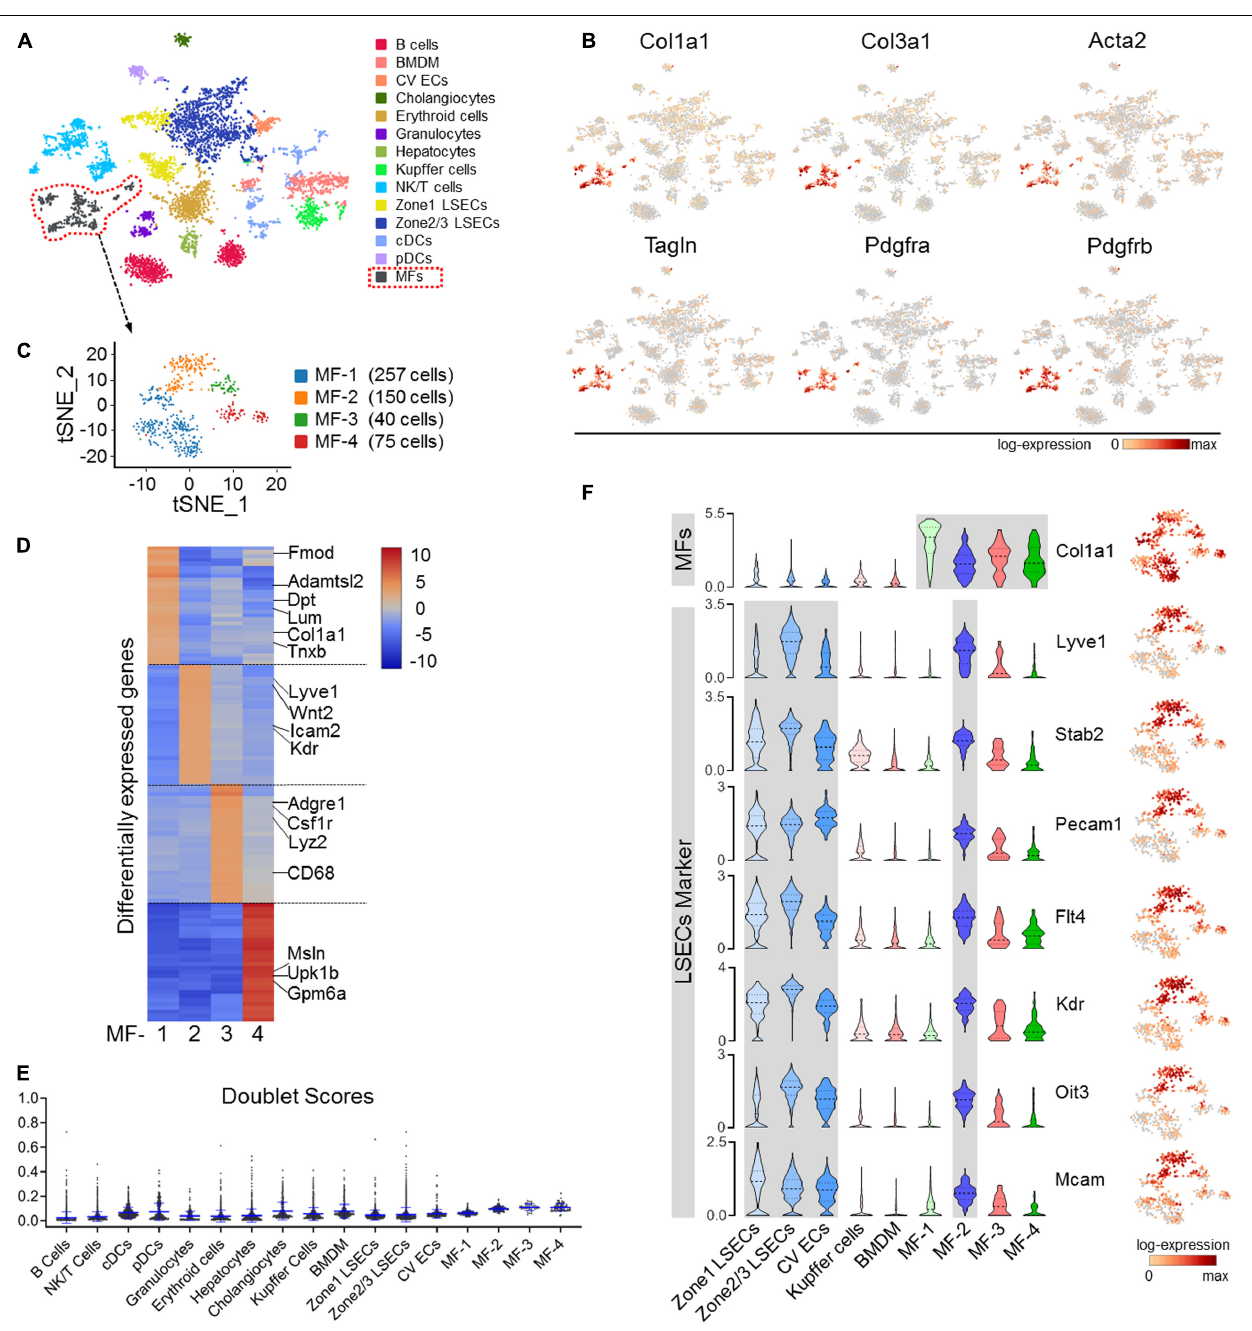
bulk-RNA sequencing on isolated LSECs. However, gene signatures reflecting EC-migration were insignificantly enriched between control and fibrotic LSECs as demonstrated by GSEA